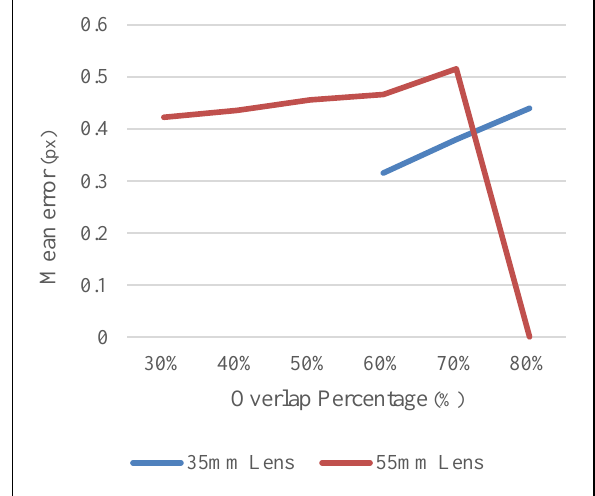
Figure 7. Triangle count per each overlap value